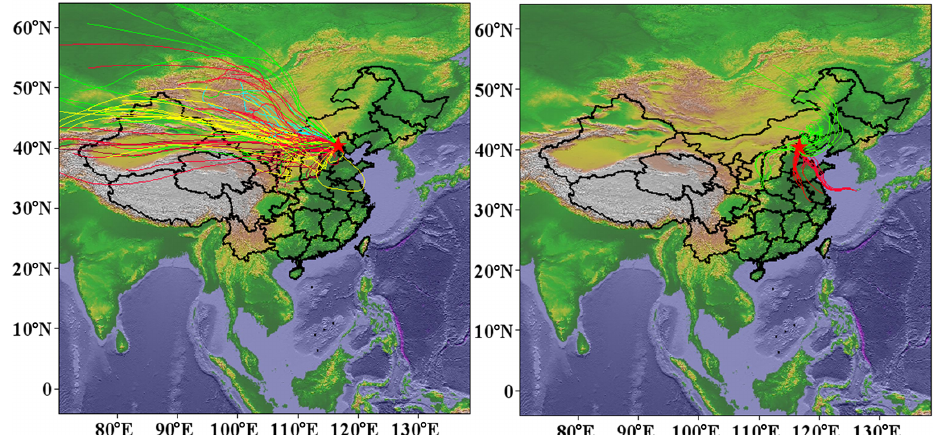
Figure 1. The sampling site and air-quality-index-weighted 72h backward trajectory of winter and summer sampling days,